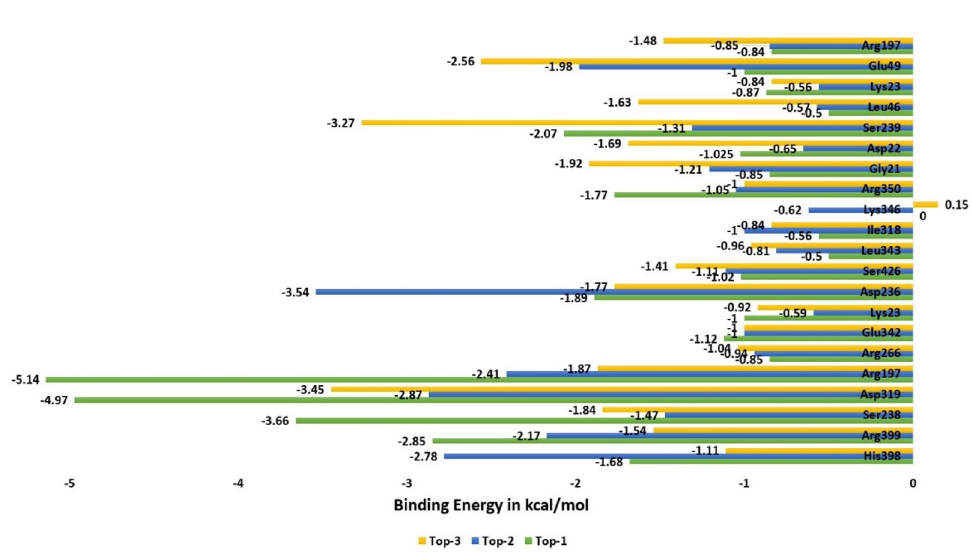
Figure 8. Net MM-GBSA binding free energy value of EPSP residues that are in direct contact with the compounds and formed the active pocket of